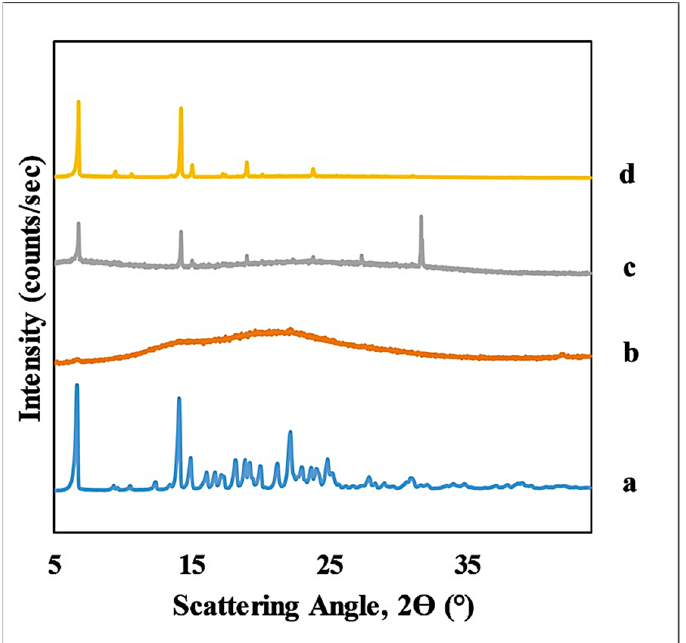
Figure 4. X-ray diffractograms of pure TEL and the solid phase isolated from the solubility suspension from the measurement at different pH: ( a ) TEL_crystalline, ( b ) 1M NaOH, ( c ) pH 9.5–10, ( d ) pH 1.6–9.